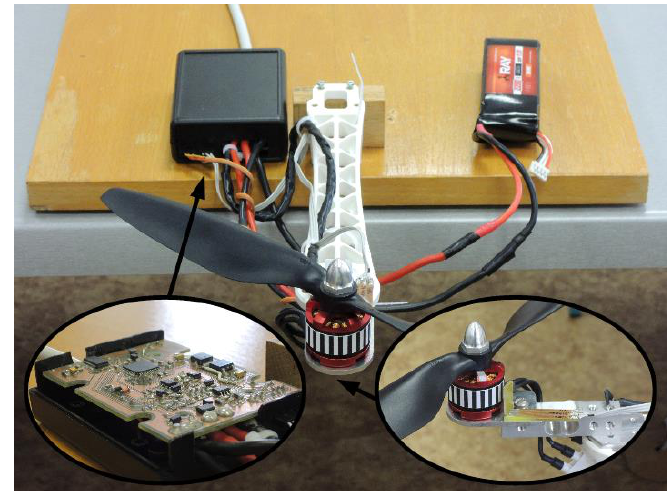
Figure 1. Test stand used to identify static and dynamic characteristics of the actuator.